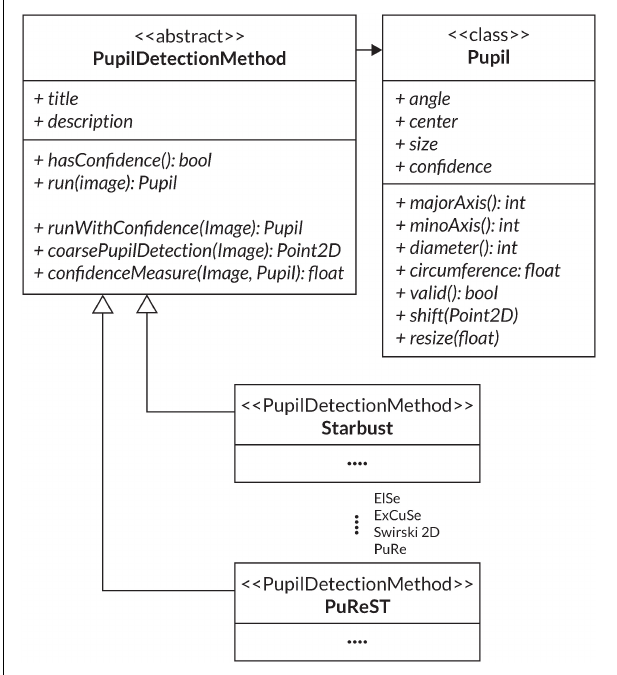
FIGURE 4 | UML diagram of the PupilDetectionMethod interface used to implement the various pupil detection algorithms. Additionally, the Pupil class is used for collecting a pupil detection